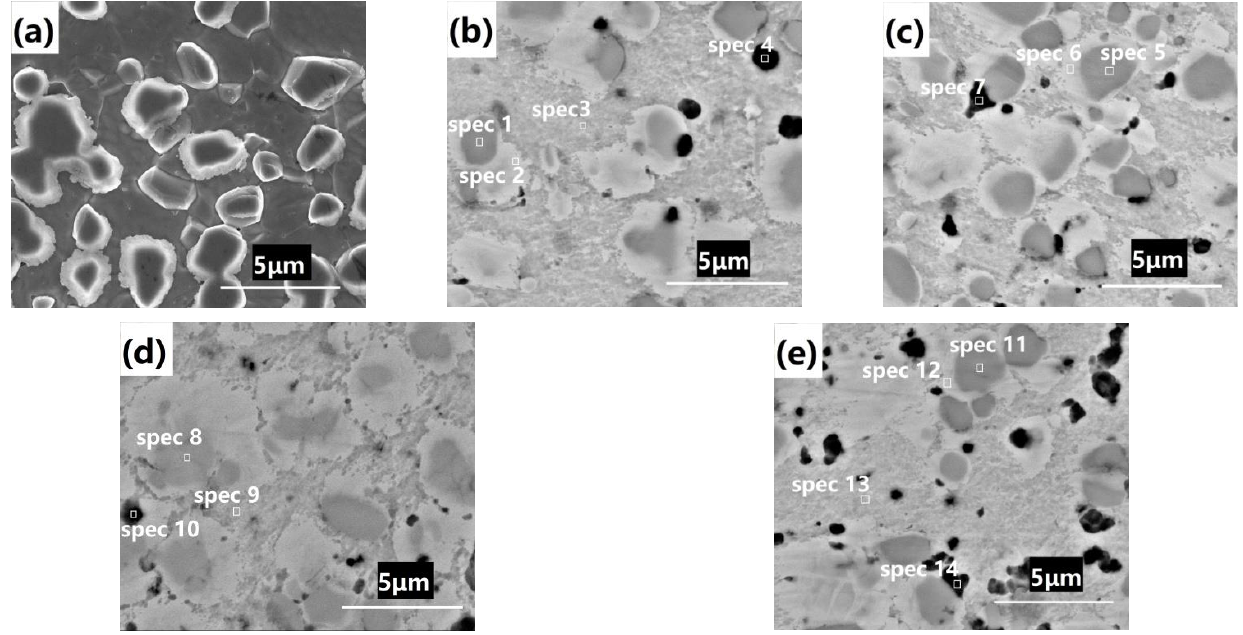
Figure 7. Microstructure of BSS ( a ) hot isostatic pressing; microstructure and EDS point analysis of BSS after hot compression test at different temperatures under different strain rates ( b ) 1000 °C and 0.01 s −1 , ( c ) 1000 °C and 10 s −1 , ( d ) 1100 °C and 0.01 s −1 , ( e ) 1100 °C and 10 s −1 .